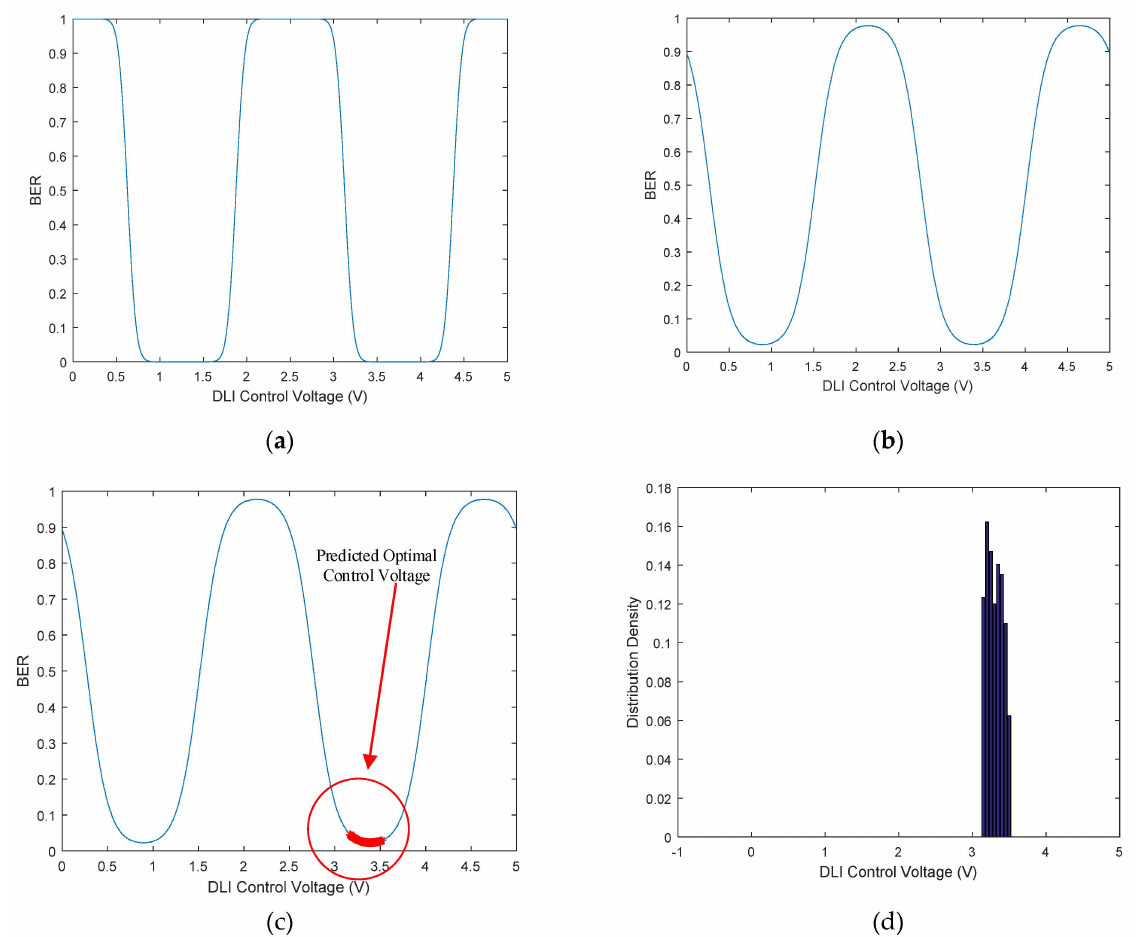
Figure 9. Simulation results: ( a ) represents the BER curve of the training data; ( b ) represents the BER curve of the test data; ( c ) marks the predicted optimal control voltage; ( d ) shows the distribution density of the predicted voltage